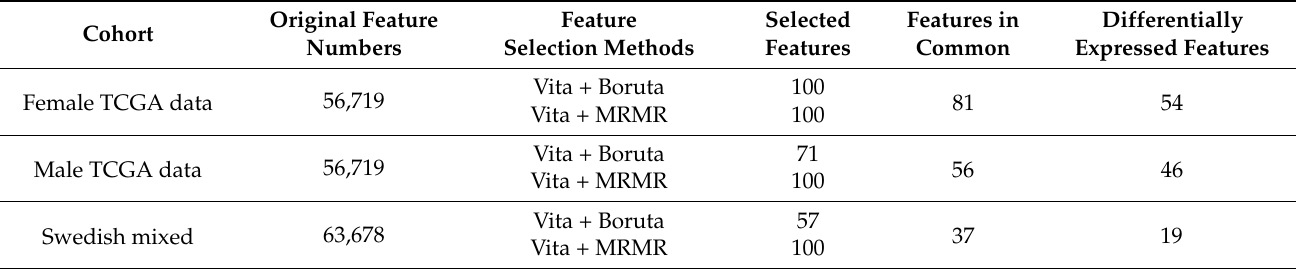
Table 1. Number of features that passed the selection criteria for female and male TCGA data, and for the Swedish mixed